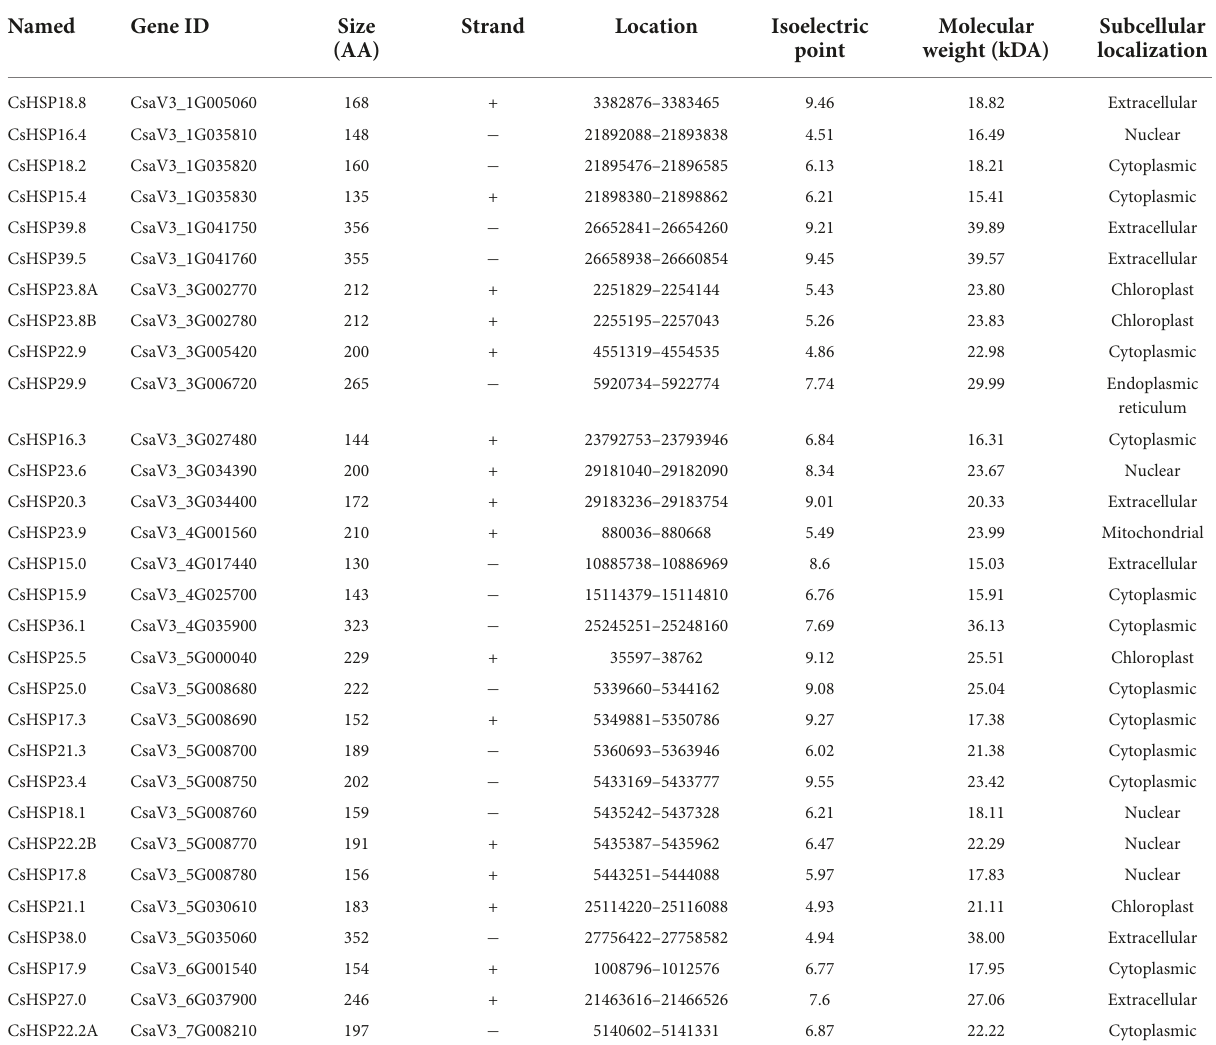
TABLE 1 The basic information of CsHSP20 proteins identified in